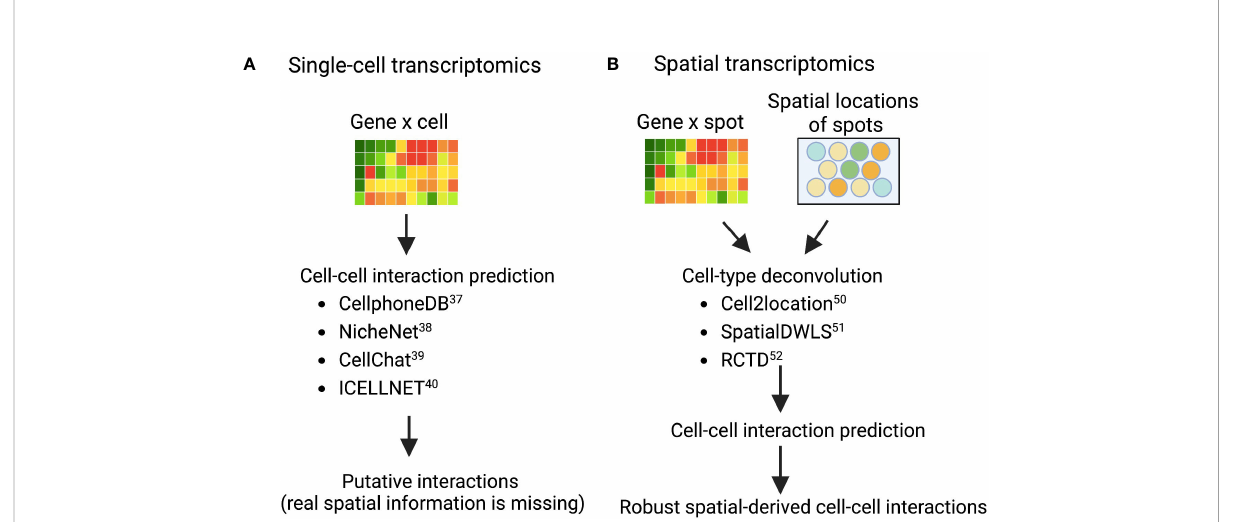
FIGURE 2 Validated computational packages to predict cell-cell interactions using (A) single-cell transcriptomics and (B) spatial transcriptomics, respectively Cell-cell interaction prediction algorithms (A) are quite adept at mapping interactions from single-cell transcriptomics where tissue architecture information was lost in sample preparation. As a result, interactions revealed in analysis are theoretical and merely suggest that cells co-located in the sample tissue. However, combining these interaction-prediction-algorithms with spatial cell-type deconvolution modeling (B) . The sample tissue ’ s spatial architecture is conserved by modeling cells that are both co-locating in the tissue and